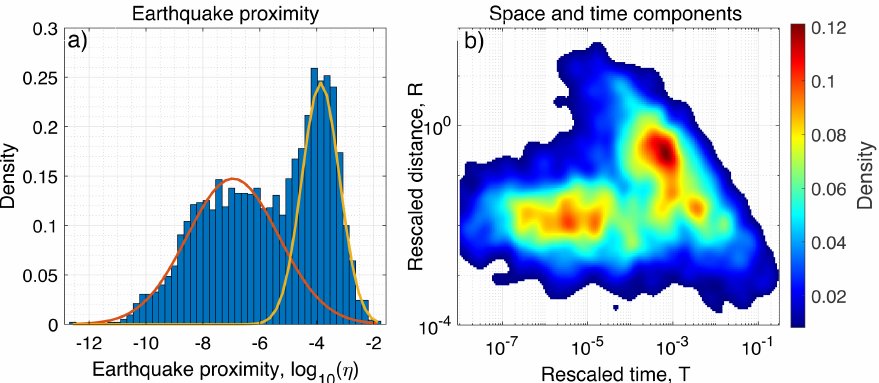
Figure A1. Distribution of the NN distances among all pairs of earthquakes of the ETAS synthetic catalog. ( a ) 1D density distribution of log η , with estimated Gaussian densities for clustered (yellow) and background (orange) components. ( b ) 2D joint distribution of rescaled space and time distances.